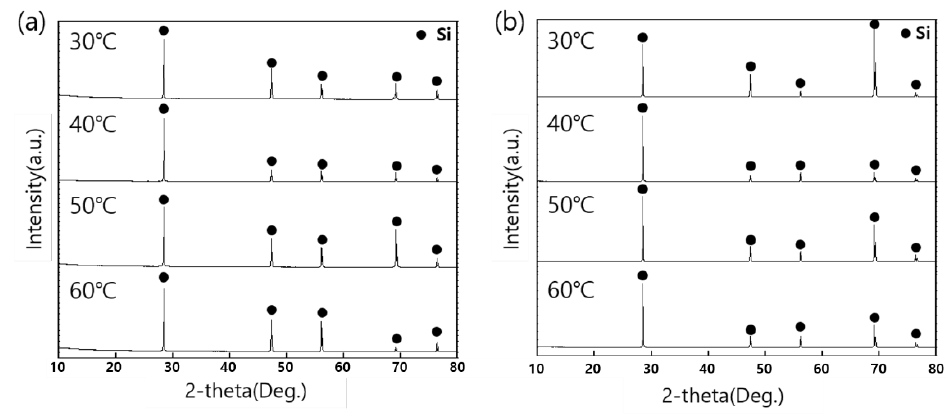
Figure 7. XRD analysis results of a photovoltaic cell after drying—temperature. ( a ) HNO 3 and ( b ) HCl.